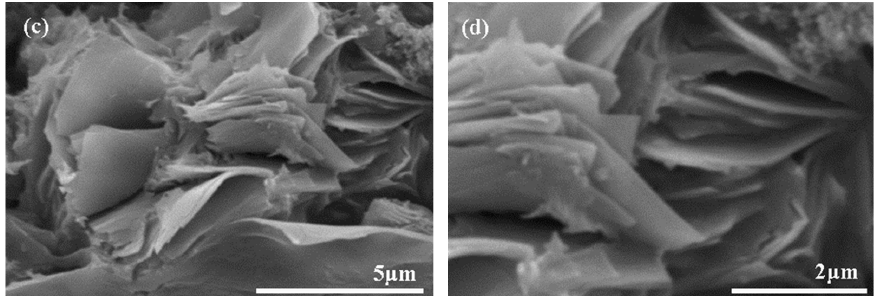
Figure 3. Cross section scanning electron microscope (SEM) images of CS/MAG ( a , b ) and CS/KH550/MAG hybrid membranes ( c , d ).